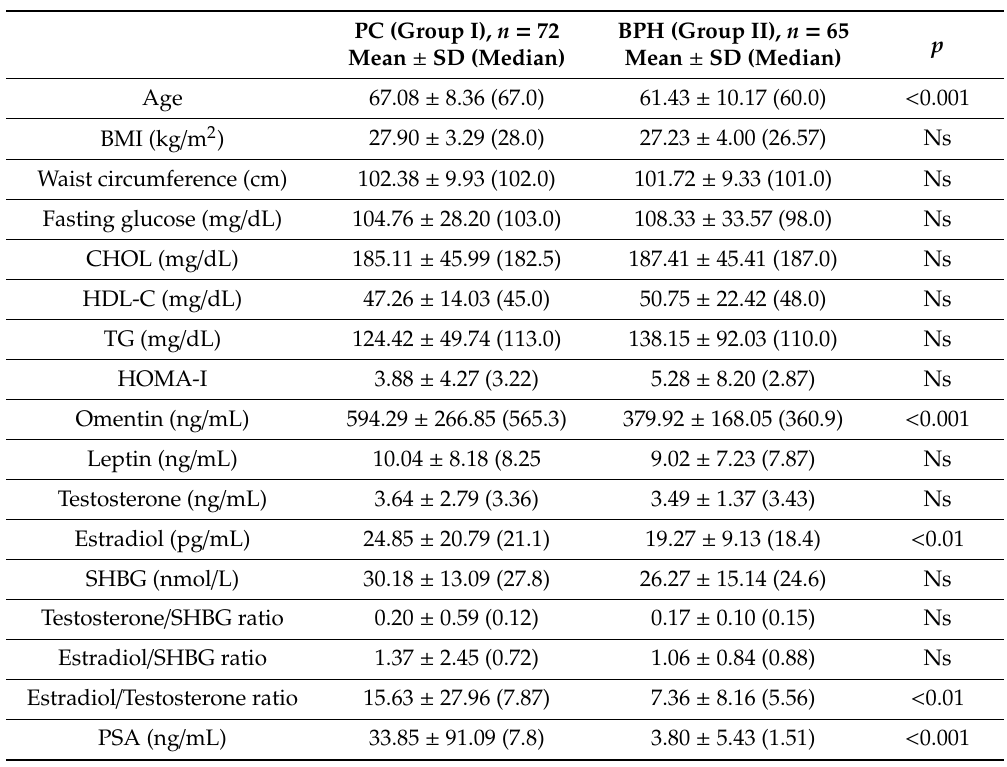
Table 1. The clinical, hormonal and metabolic parameters of studied men and comparison between the groups (Group I: PC (prostate cancer), Group II: BPH (benign prostate